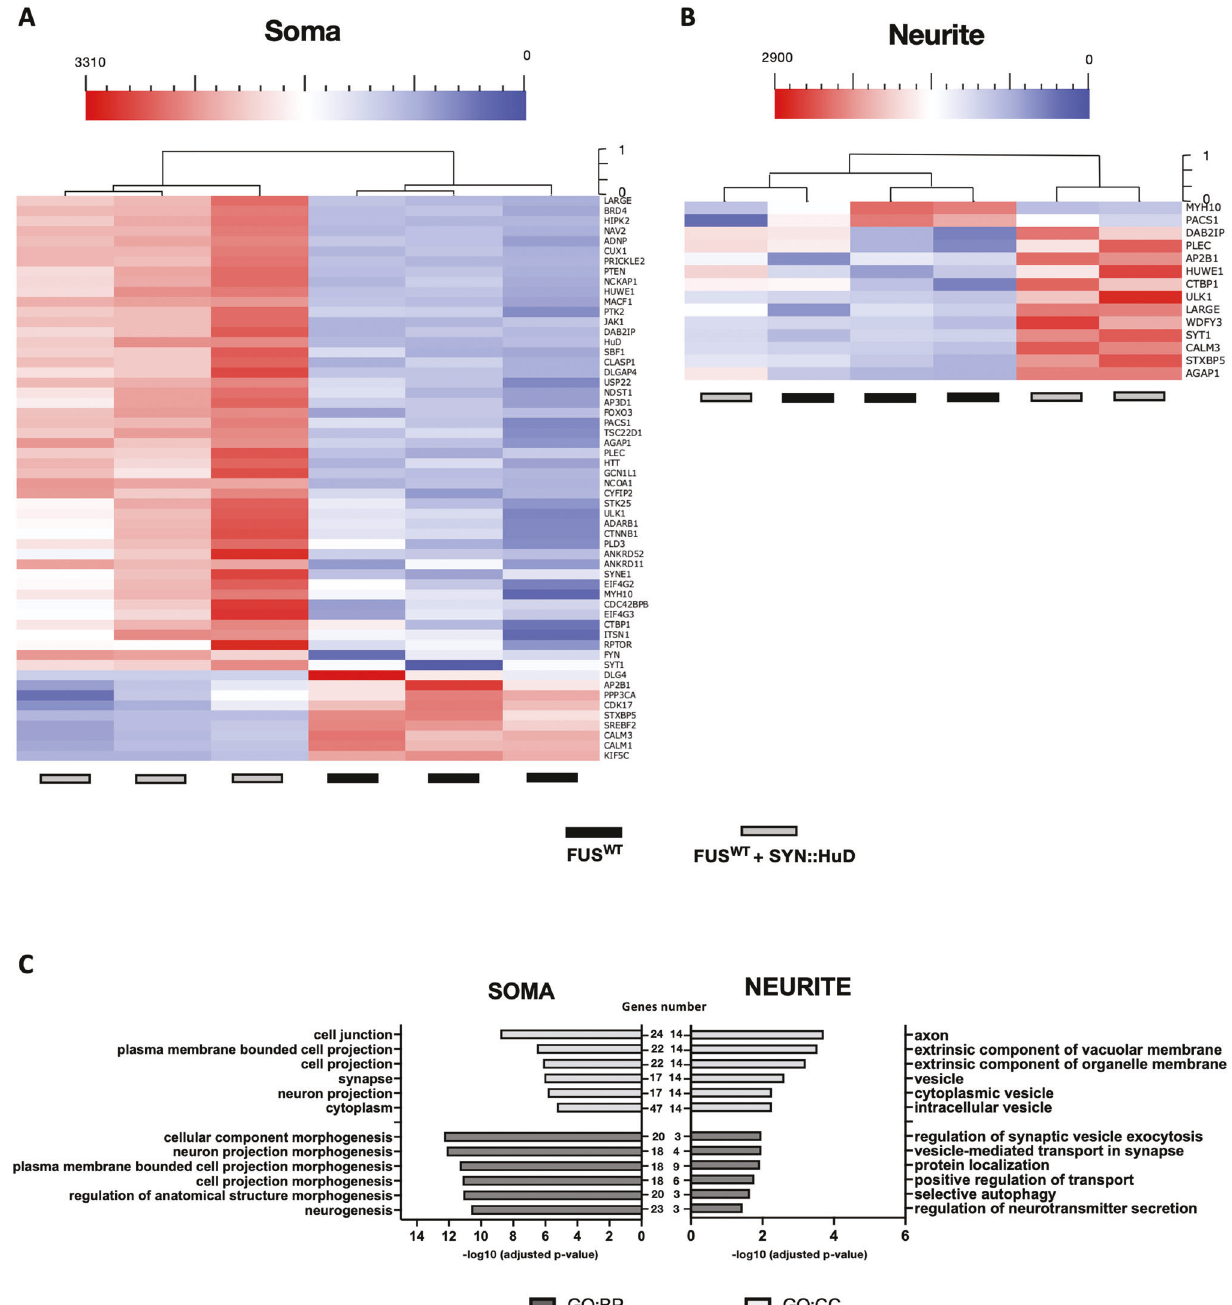
Fig. 4 Differentially expressed genes in soma and neurite of FUS WT and FUS WT SYN::HuD MNs. A , B Unsupervised cluster representing the RNA molecules count of differentially expressed genes in the cell body ( A ) or neurite ( B ) compartment of iPSC-derived FUS WT MNs and MNs derived from a stably transfected FUS WT iPSC line expressing a HuD transgene under the control of the neuronal-speci fi c human synapsin 1 promoter (SYN1::HuD). Plotted values correspond to normalized RNA molecules as described in the Methods section. Red, higher abundance; blue, lower abundance. C Bar graph representation of the top 6 GO terms enriched in differentially expressed genes as in ( A , B ). The − log10(adjusted p -value) and number of genes are positive controls and the housekeeping genes ATP5O and THYN . Back- ground subtraction and data normalization were performed for each independent class comparison. Gene expression was averaged across the three independent replicate samples. GraphPad Prism 6.0 (GraphPad Software, San Diego, CA, USA) was used to determine differentially expressed genes; a Wilcoxon signed-rank test (for two conditions) or one- way ANOVA (for three conditions) was performed on the sample normalized data to determine statistical signi fi cance. Unsupervised hierarchical clustering and Gene ontology analysis of differentially